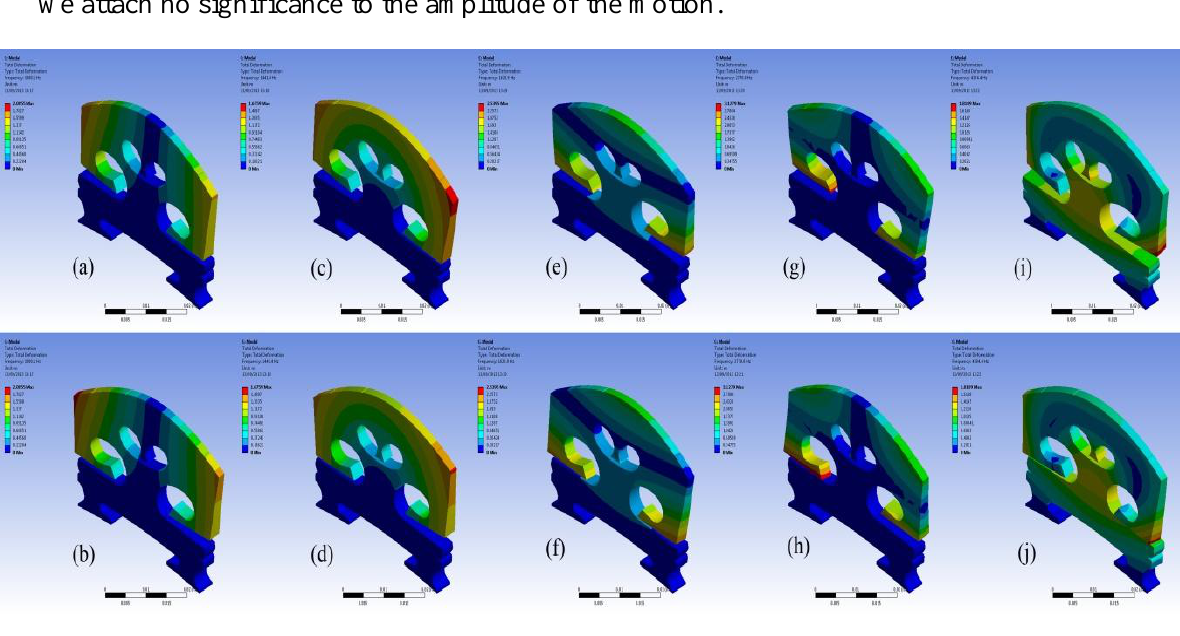
Figure 4. Bridge motion of different resonance modes in Table 2. ( a ) and ( b ): mode 2; ( c ) and ( d ): mode 3; ( e ) and ( f ): mode 4; ( g ) and ( h ): mode 5; ( i ) and ( j ): mode 7. Note that we attach no significance to the amplitude of the